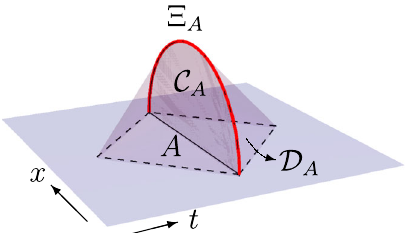
Fig. 1 Schematic depiction of the entanglement wedge E A and causal wedge C A for a boundary subregion A , or equivalently, for its boundary domain of dependence D A . See the main text for the explicit defini- tions. For arbitrary bulk geometries, the entanglement wedge, bounded by null geodesics that are shot towards the boundary from the Ryu– Takayanagi surface (cid:2) A , is larger than the causal wedge, bounded by null geodesics that are shot into the bulk from the edge of D A . The